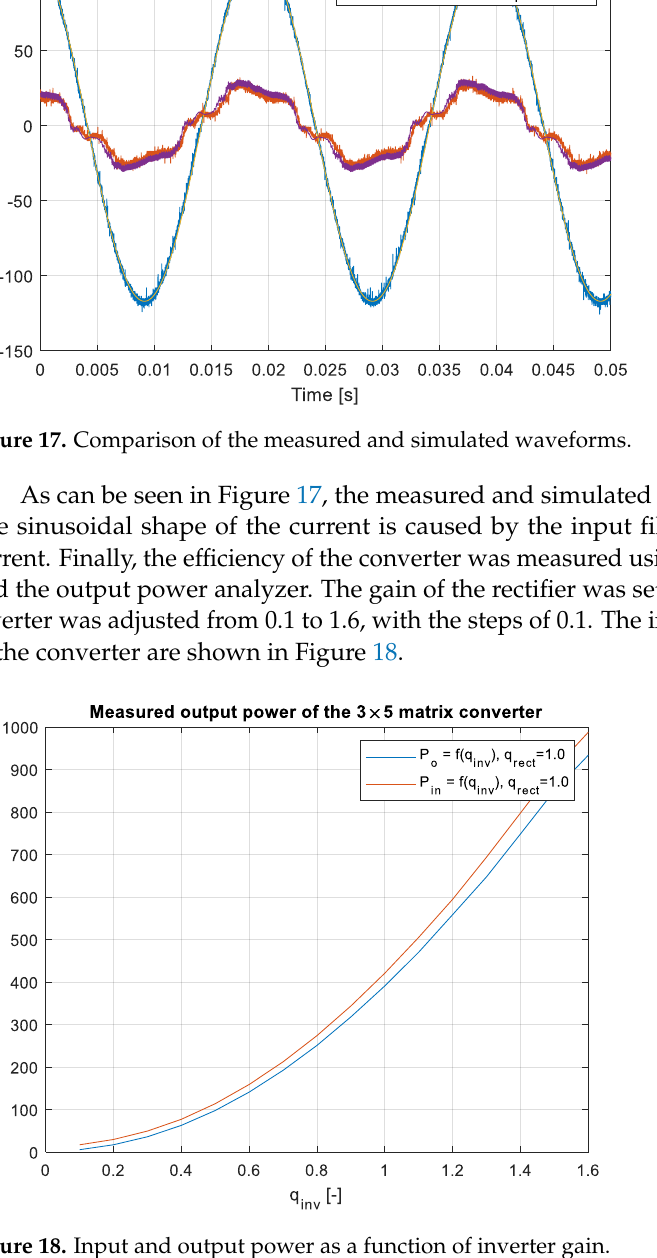
ulink environment was created to confirm the practical results and compare them to the